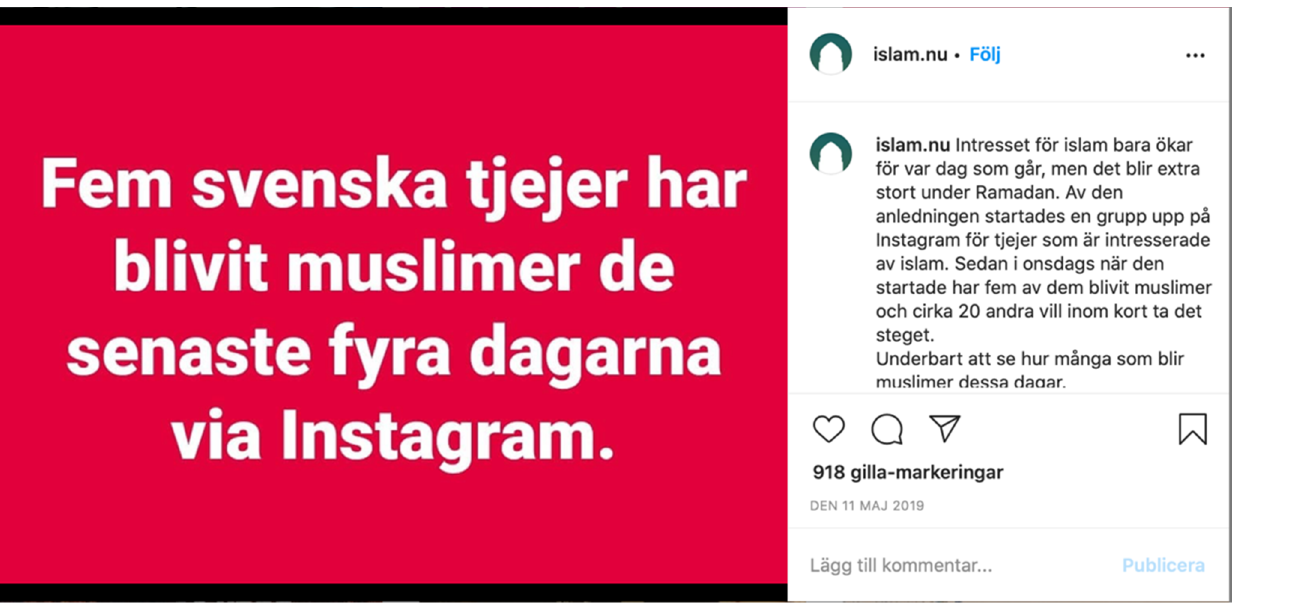
Figure 4. “Five Swedish girls have become Muslims over the past four days via Instagram.”.